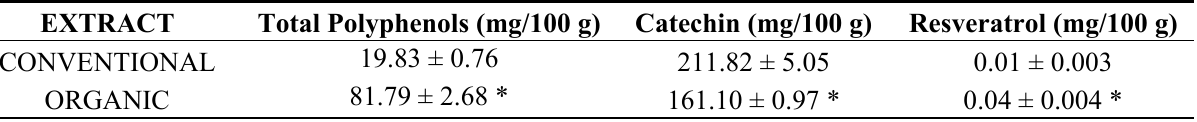
Table 1. Content of total polyphenols, catechin and resveratrol in V. labrusca leaf extracts using organic and conventional